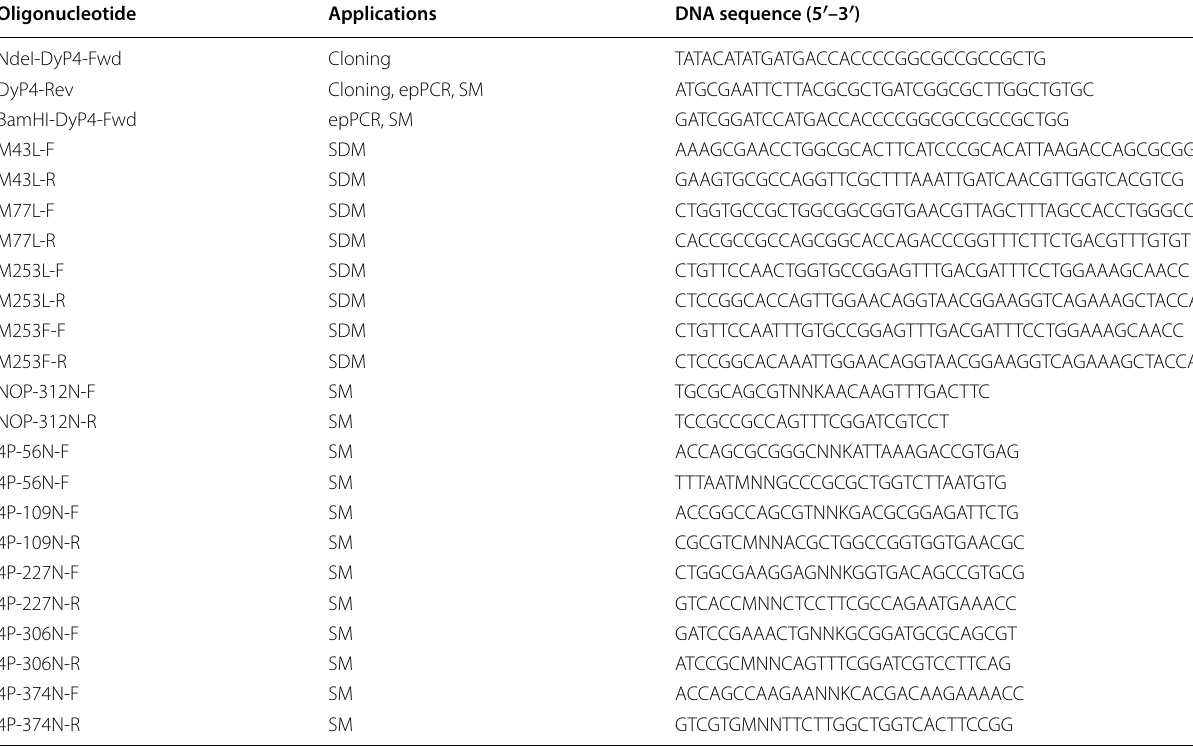
epPCR error-prone polymerase chain reaction, SDM site-directed mutagenesis, SM saturation mutagenesis